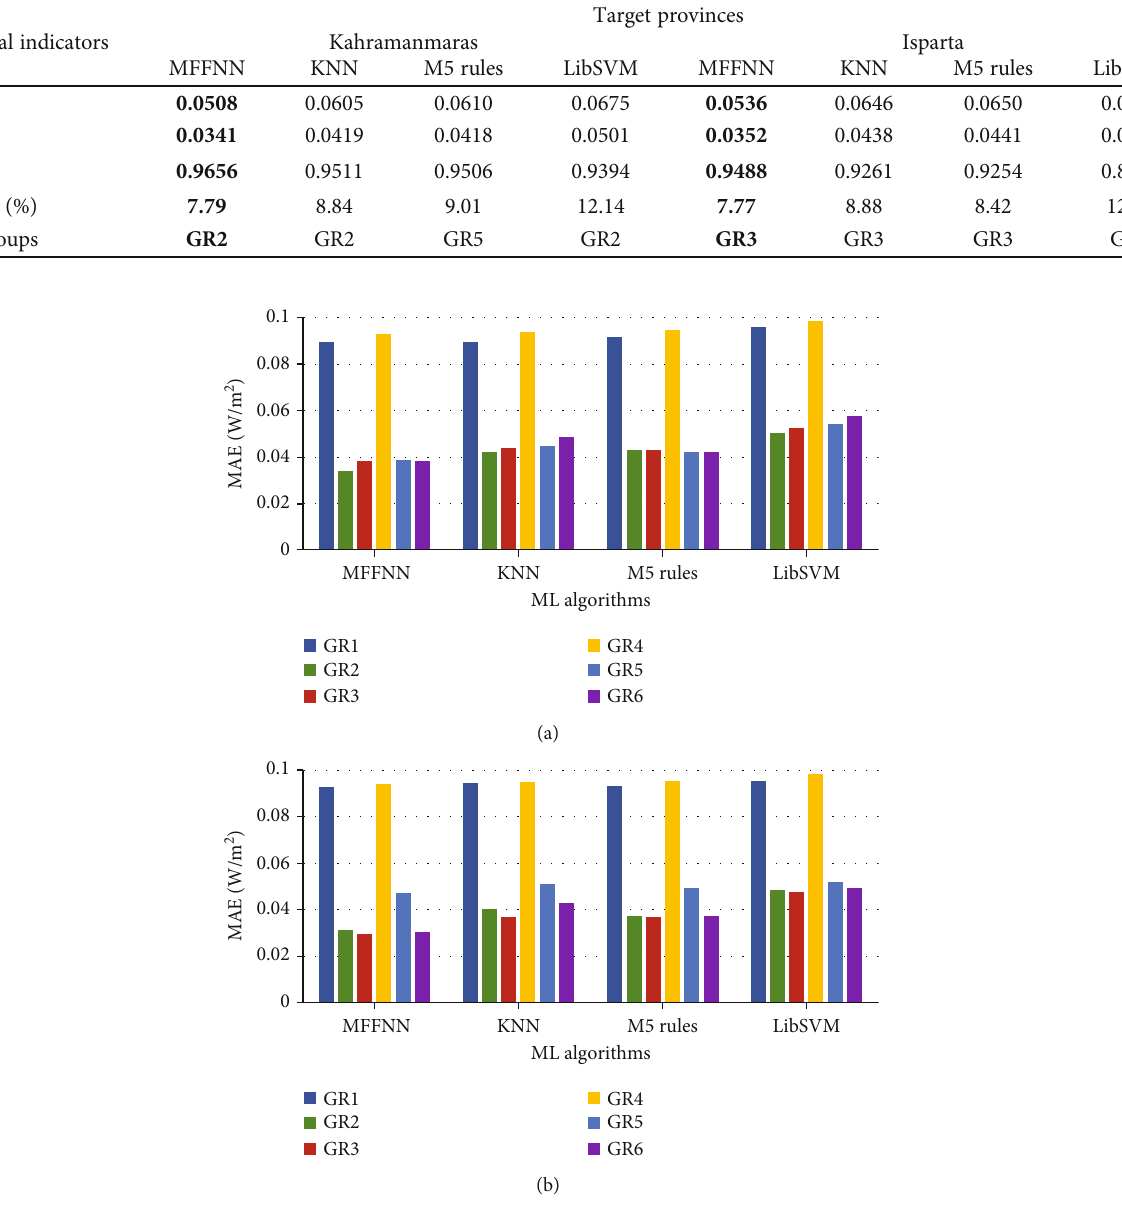
Figure 15: MAE performance comparisons of the best models developed by using ML algorithms according to data groups for (a) Kahramanmaras and (b) Isparta.